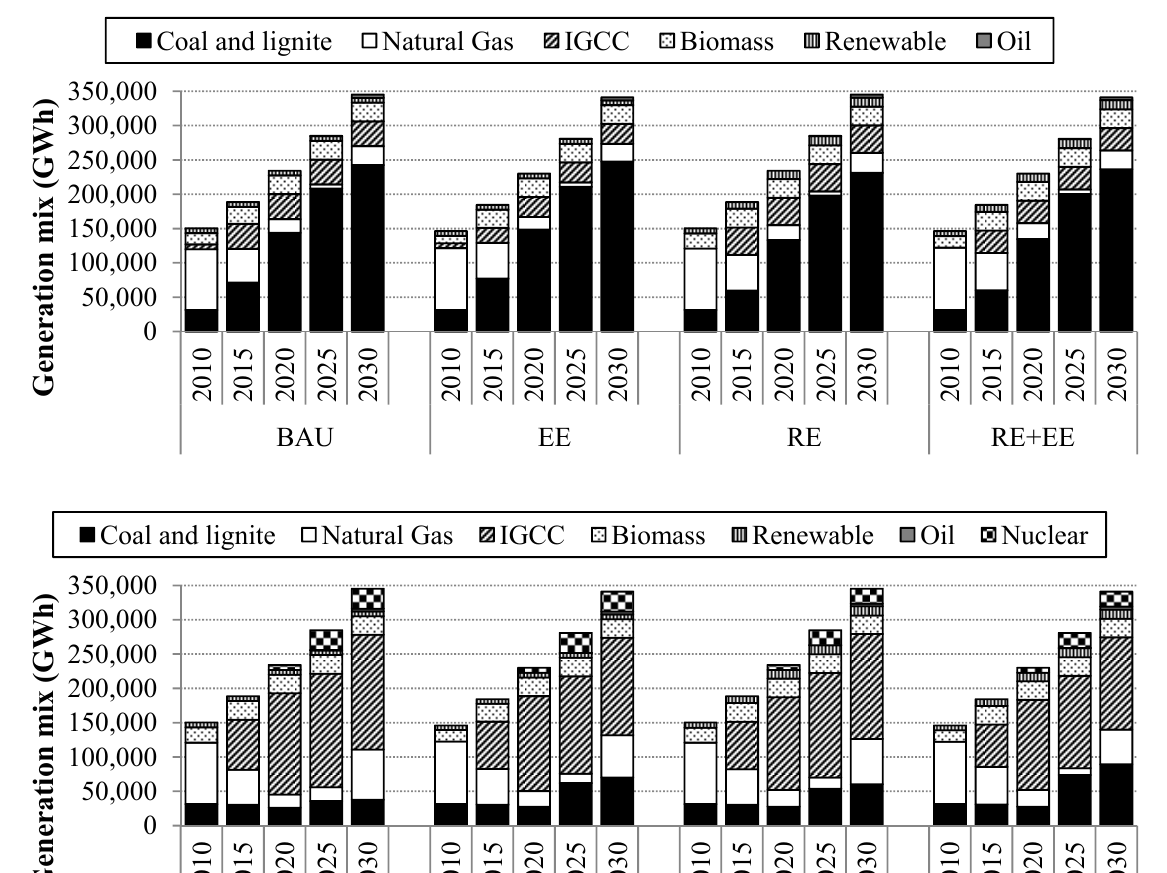
Figure 2. Generation mixes in all